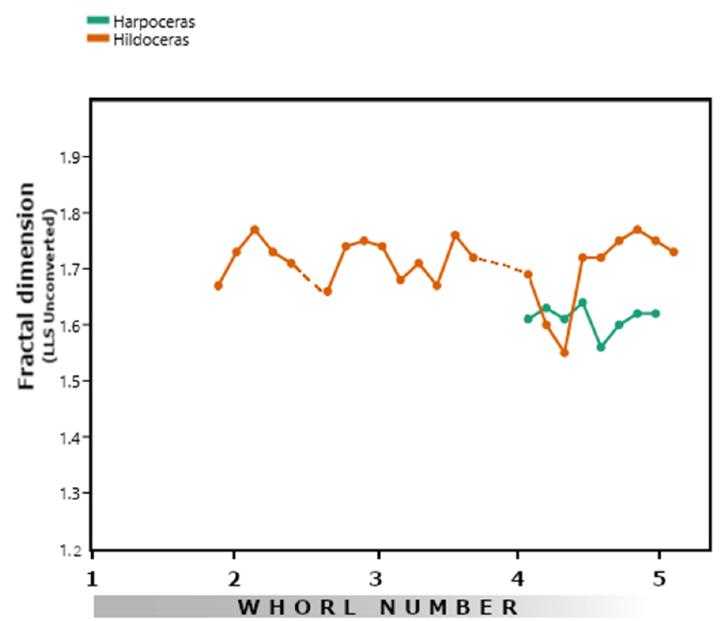
Figure 5. Ontogenetic sequences of hildoceratid suture complexity. The dashed lines indicate an unusable suture in the sequence. The fractal dimensions can be found in File S1 in the Supplementary Materials.